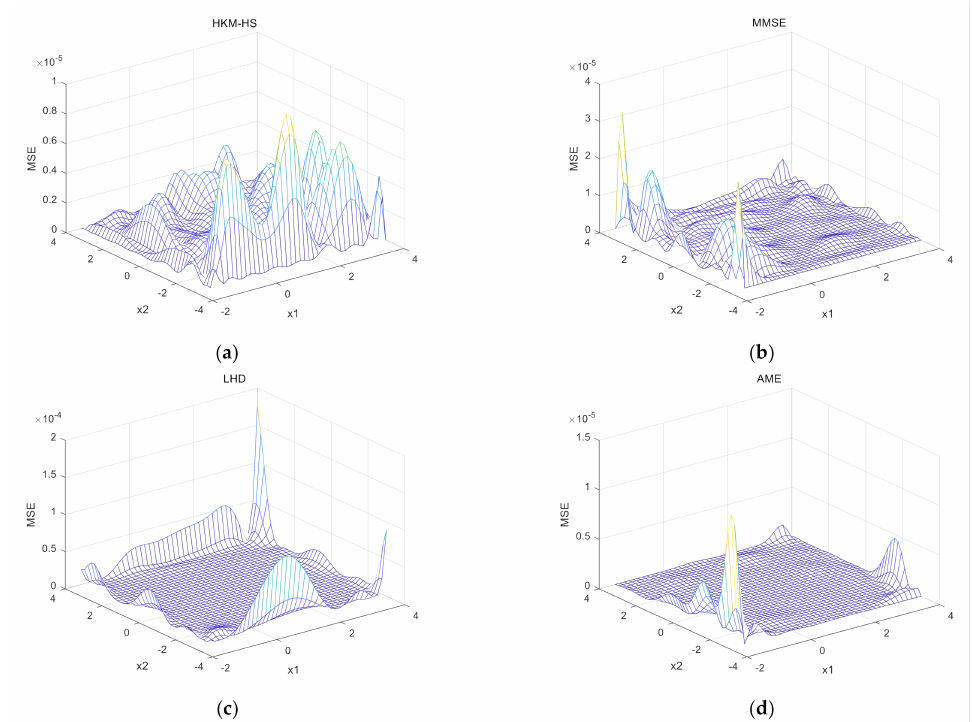
Figure 6. ( a )Test result of Mccormick function by HKM-HS; ( b ) Test result of Mccormick function by maximum mean square error (MMSE); ( c ) Test result of Mccormick function by Latin Hypercube Design (LHD); ( d ) Test result of Mccormick function by adaptive maximum entropy (AME).